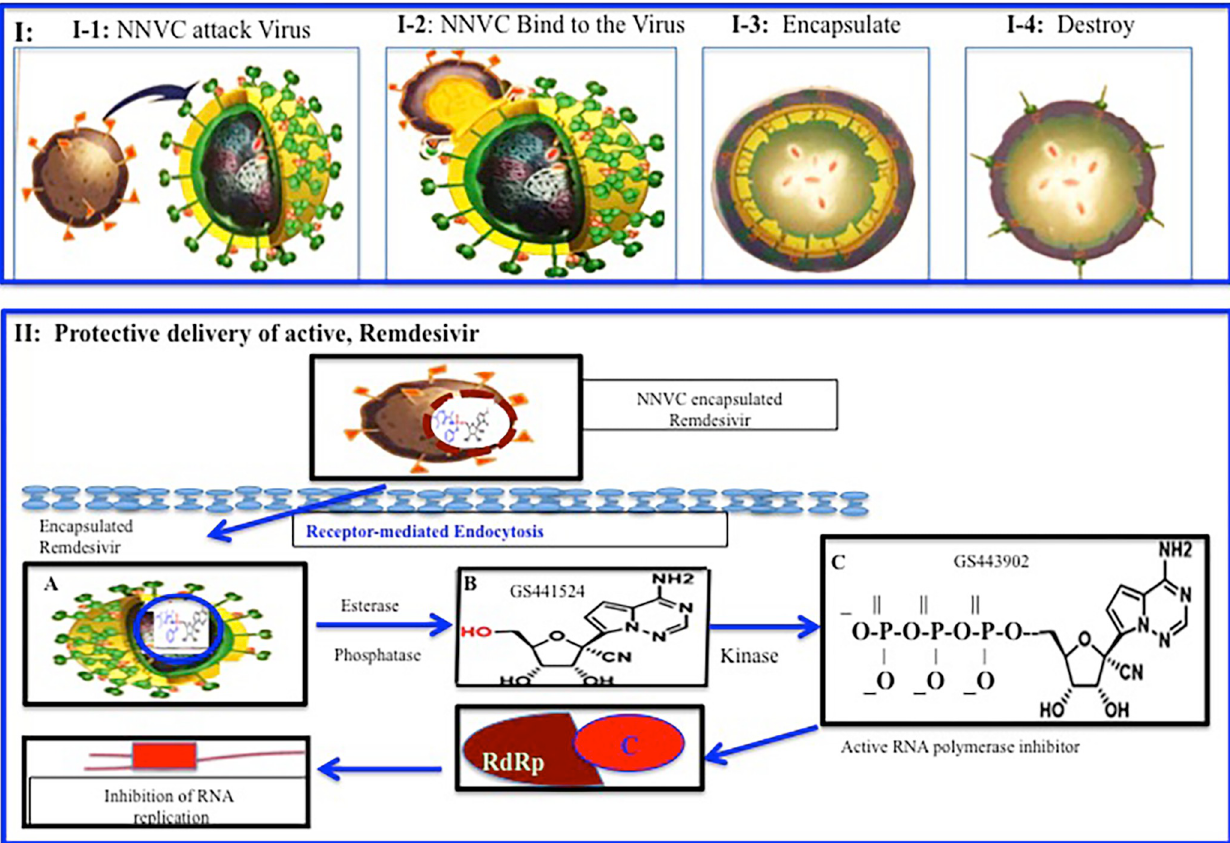
Fig 7. Graphical representation of NV-CoV-2 action